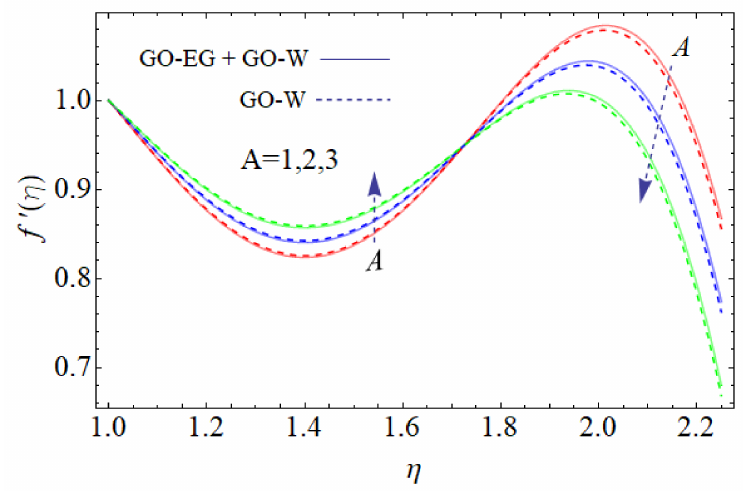
Figure 2. Influence of the injection parameter on the velocity